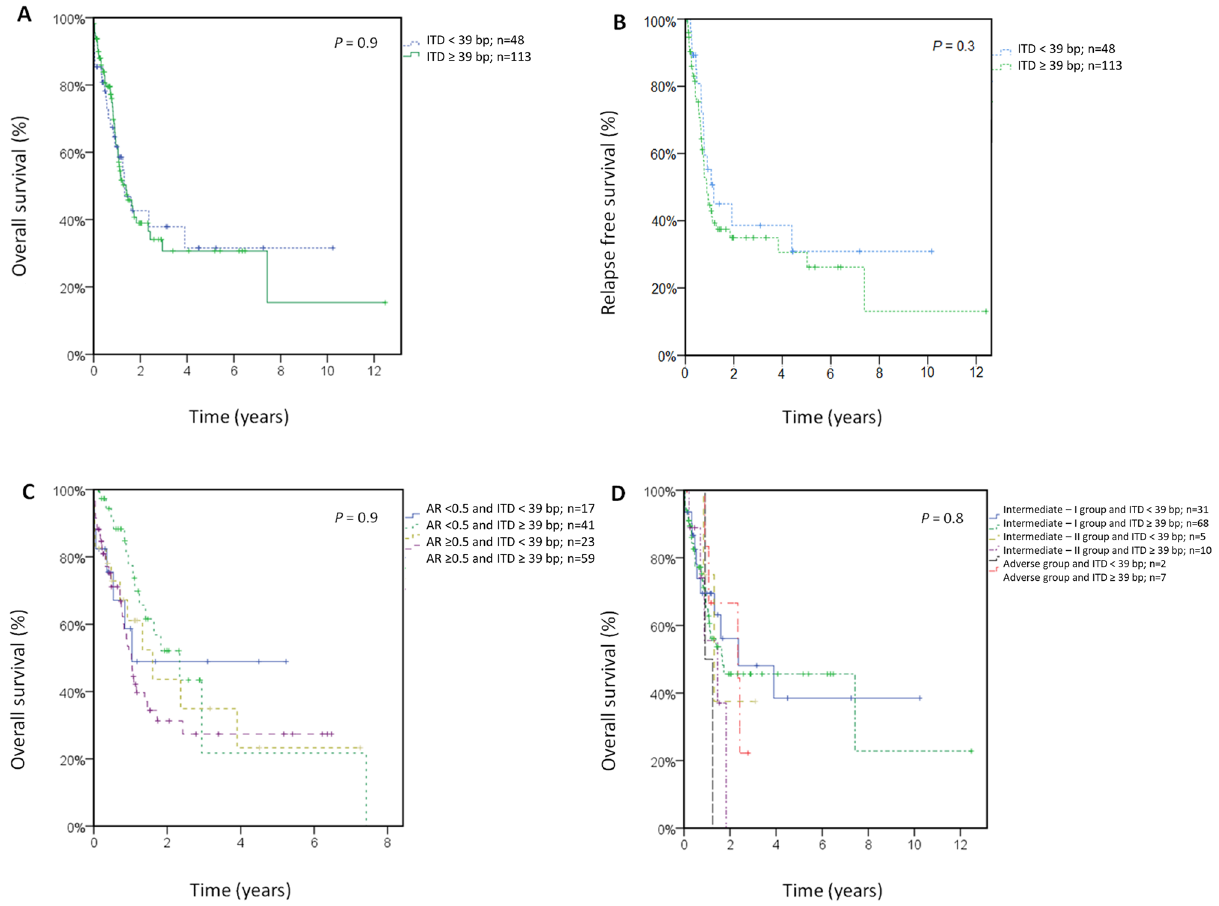
Figure 1. Clinical outcome stratified according to the FLT3 -ITD length (cutoff 39 bp) for all patients treated with intensive chemotherapy. ( A ) Overall survival. ( B ) Relapse-free survival. ( C ) OS according to the FLT3 -ITD length and allelic ratio. ( D ) OS according to the FLT3 -ITD length and 2010 ELN genetic risk. AR,allelic